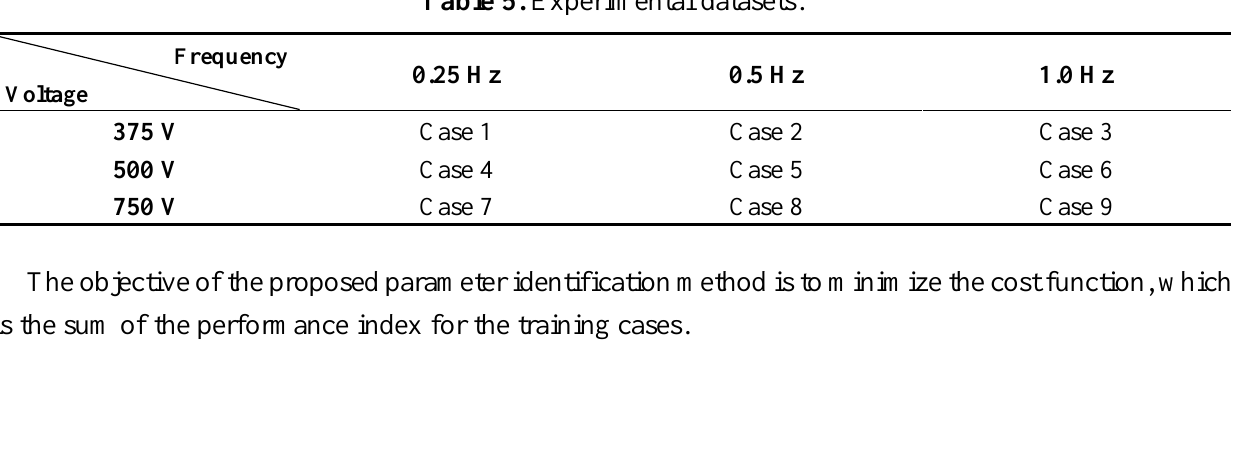
Table 5. Experimental